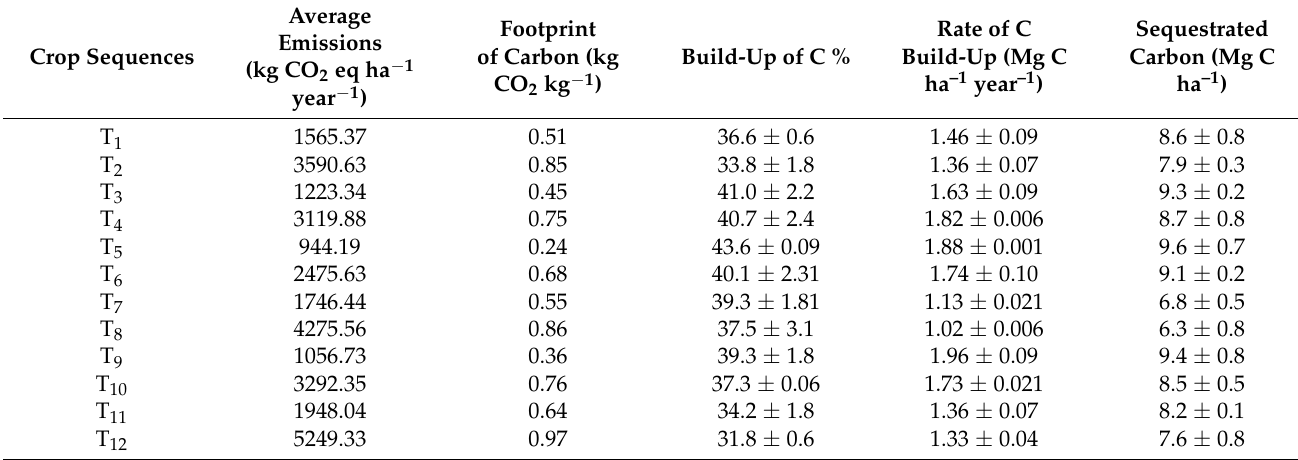
Table 8. Average emissions and the C-footprint under alternative cropping systems with levelling options from 2009–2015.